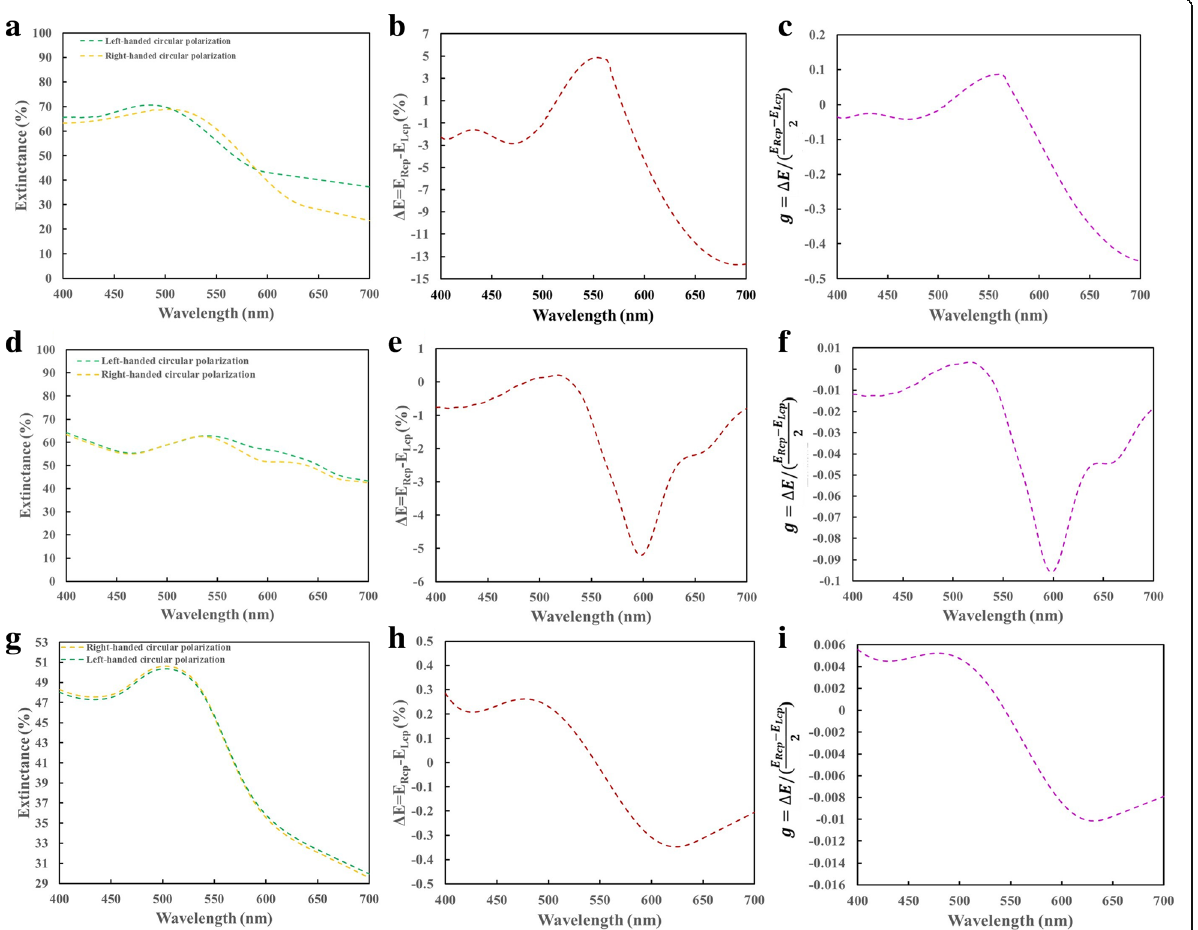
Fig. 7 Simulated extinctance, extinctance difference ( Δ E), and the g-factor spectra of sample 1 ( a – c ), sample 2 ( d – f ), and sample 3 ( g – i